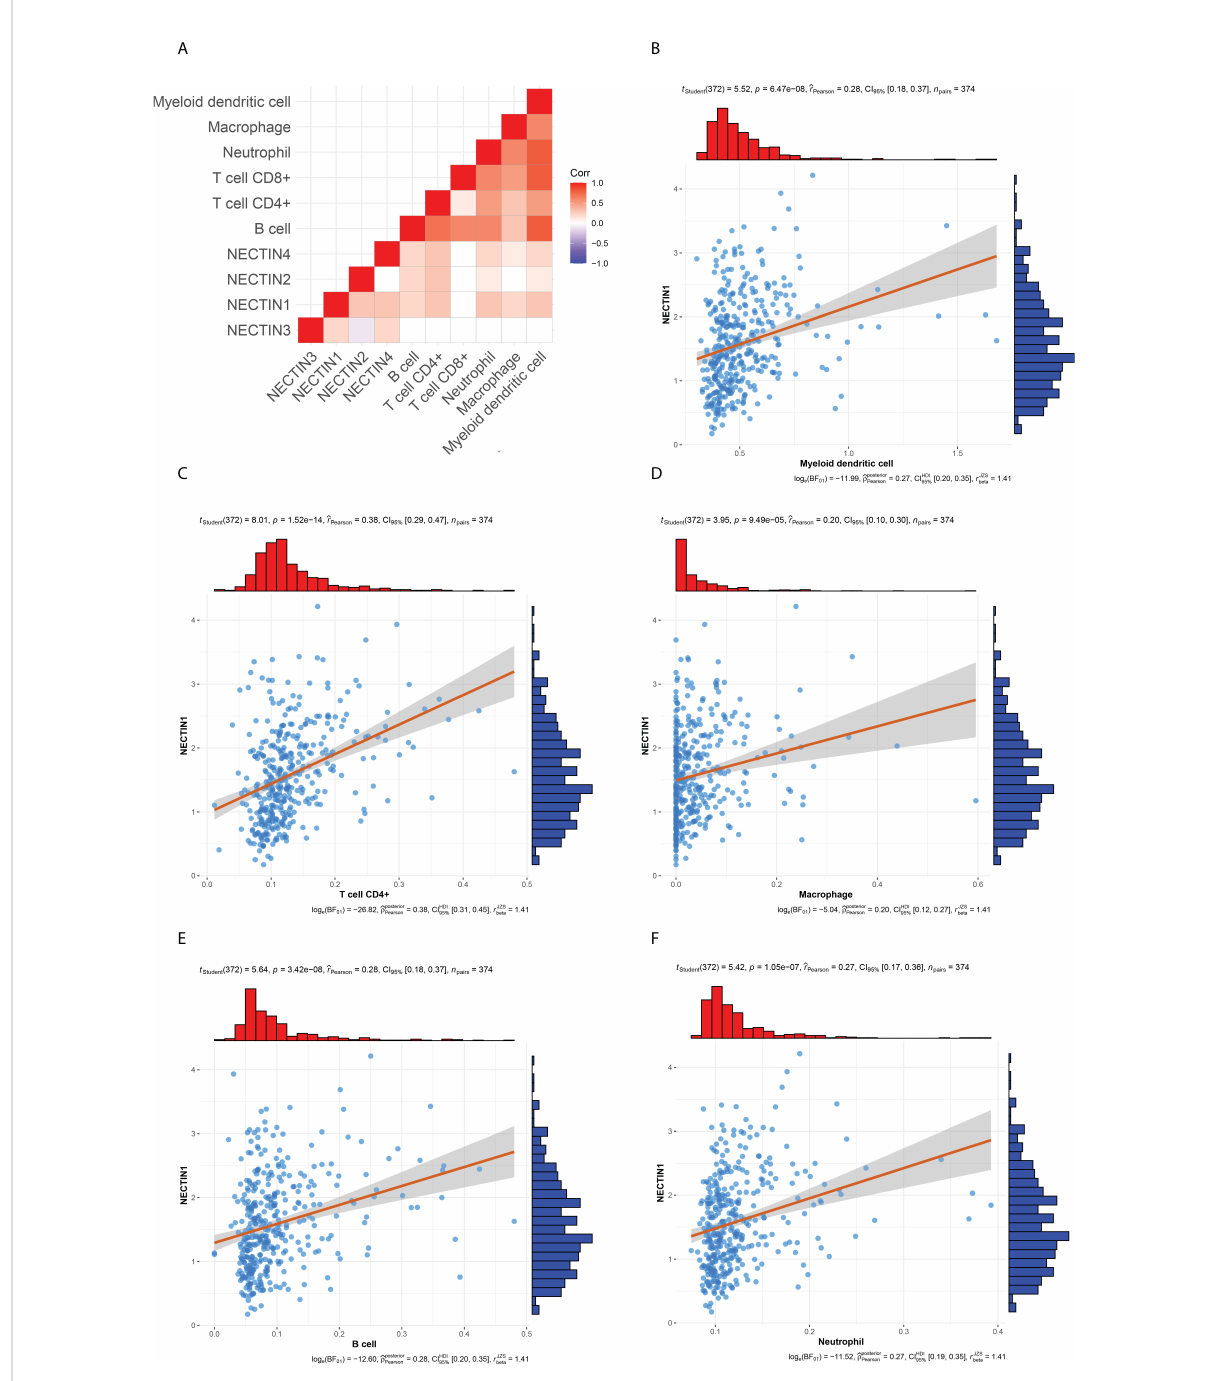
FIGURE 7 Timer and correlation analysis between nectin-1 and immune cell in fi ltration in HCC tissues. (A) Timer analysis of immune cell in fi ltration in HCC. (B) Correlation analysis between nectin-1 and myeloid DC. (C) Correlation between nectin-1 and CD4 + T cells. (D) Correlation between nectin-1 and macrophage. (E) Correlation between nectin-1 and B cells. (F) Correlation between nectin-1 and neutrophil